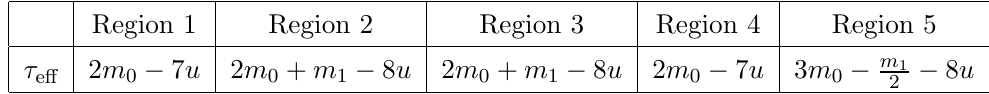
0) for Region 1{Region 5. (cid:20)